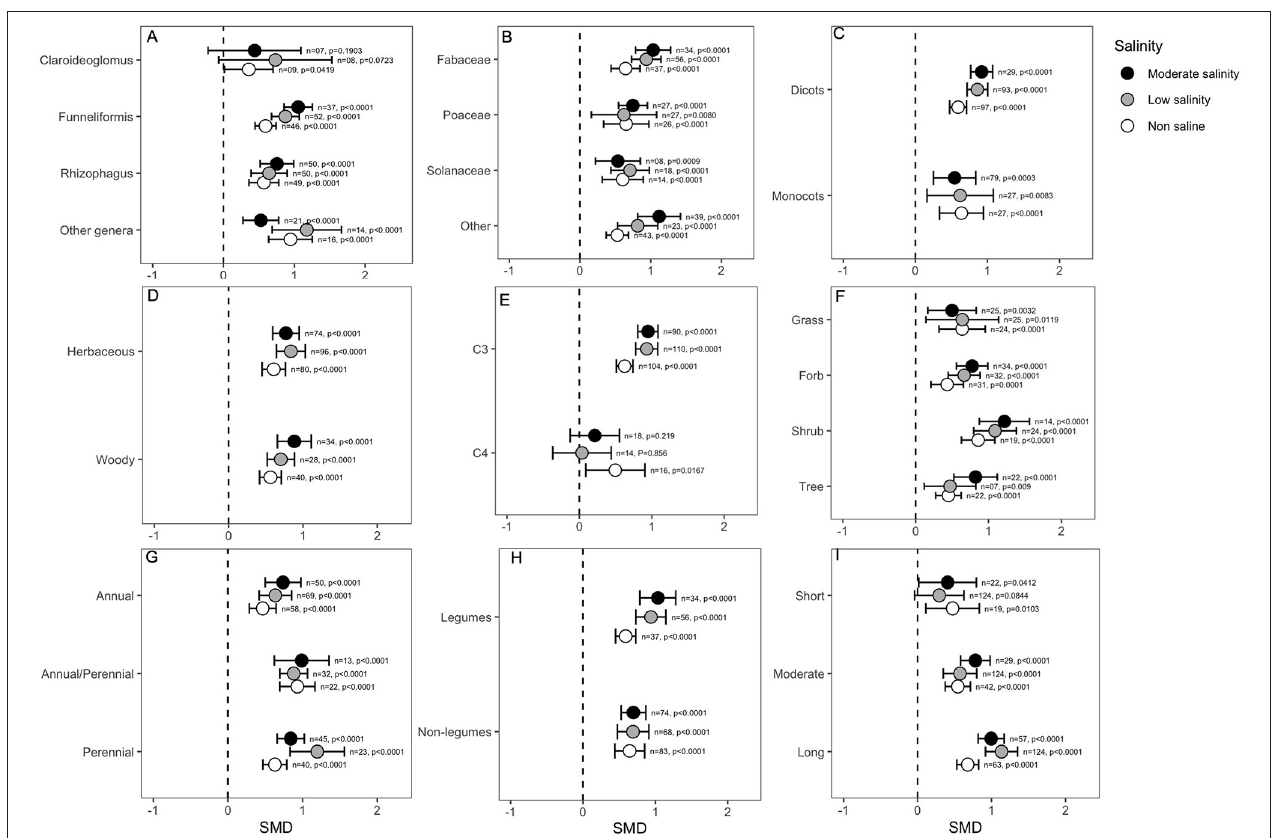
FIGURE 4 | Effects of mycorrhizae on plant shoot biomass under non-saline, low salinity, and moderate salinity conditions for various categorical variables such as (A) Fungal genera, (B) Plant Family, (C) Plant clade, (D) Plant lifestyle, (E) Plant Photosynthetic pathway, (F) Plant Life forms, (G) Plant lifecycle, (H) Plant nodulation, and (I) Salinity duration. Error bars are the effect size means 95% CIs. Where the CIs do not overlap the vertical dashed lines, the effect size for a parameter is significant, ± i.e., the growth responses of AMF plants were significantly different from those of non-AMF plants. n , number of studies included in the meta-analysis; p , significance level of